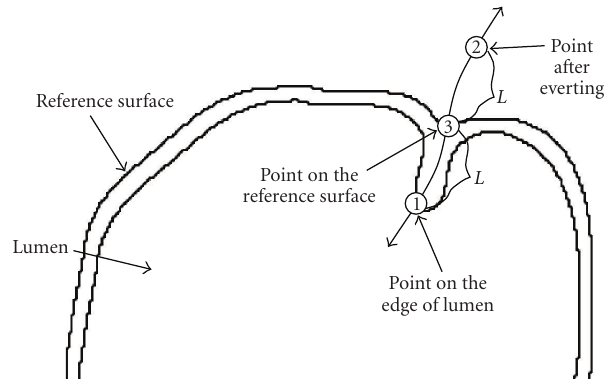
Figure 5: Everting process for a point on the reference surface. Along the curved electrical force line, the length from (1) to (3) equals the length from (3) to